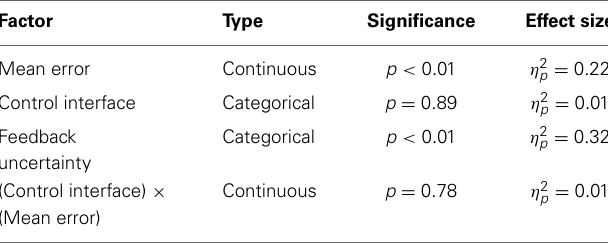
Table 1 | Results of Three-Way ANOVA on adaptation